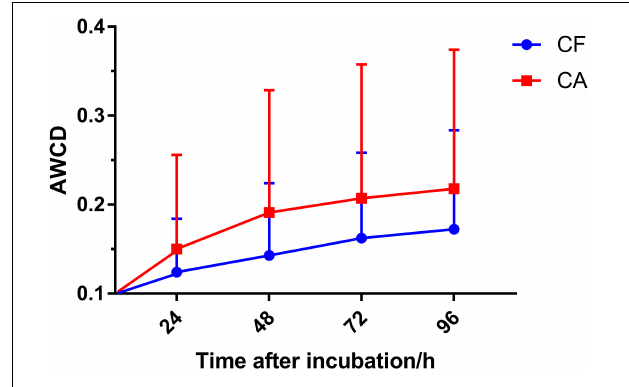
FIGURE 1 | Average well color development (AWCD) value with incubation time in the CF and CA groups. Plaque microbiota samples were tested using Biolog AN plate, AWCD value was calculated at 24, 48, 72, and 96 h after incubation. Mean values ± SD are shown. Mann-Whitney U -test was used for statistical analysis ( P >